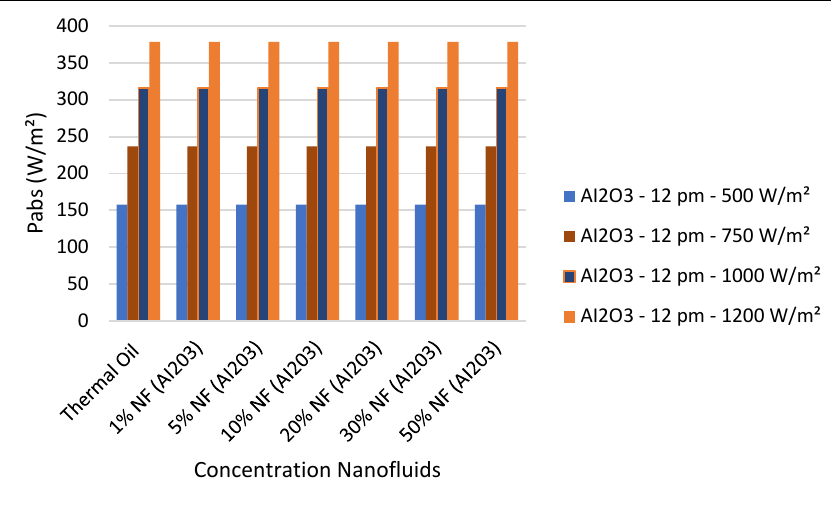
Figure 19. Power absorbed by CSP collector at different concentrations of Al 2 O 3 .